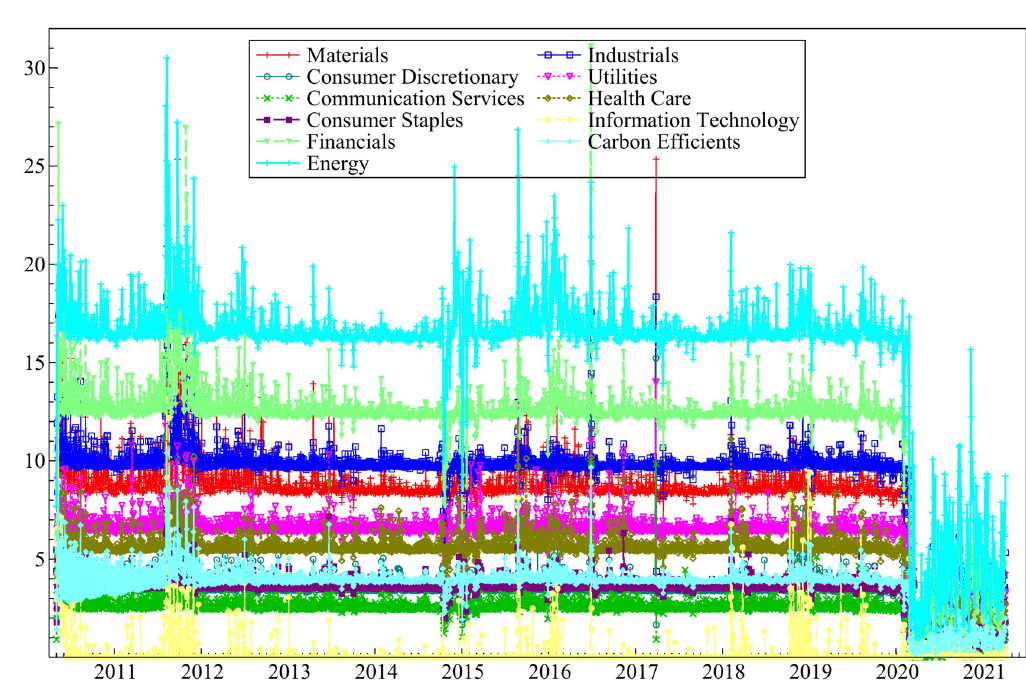
Fig 8. Dynamic optimal weights strategy results. Time-varying optimal weights of each sectoral indices in the IEMV-sectoral index diversified portfolios (https://ndownloader.figshare.com/files/29099883).